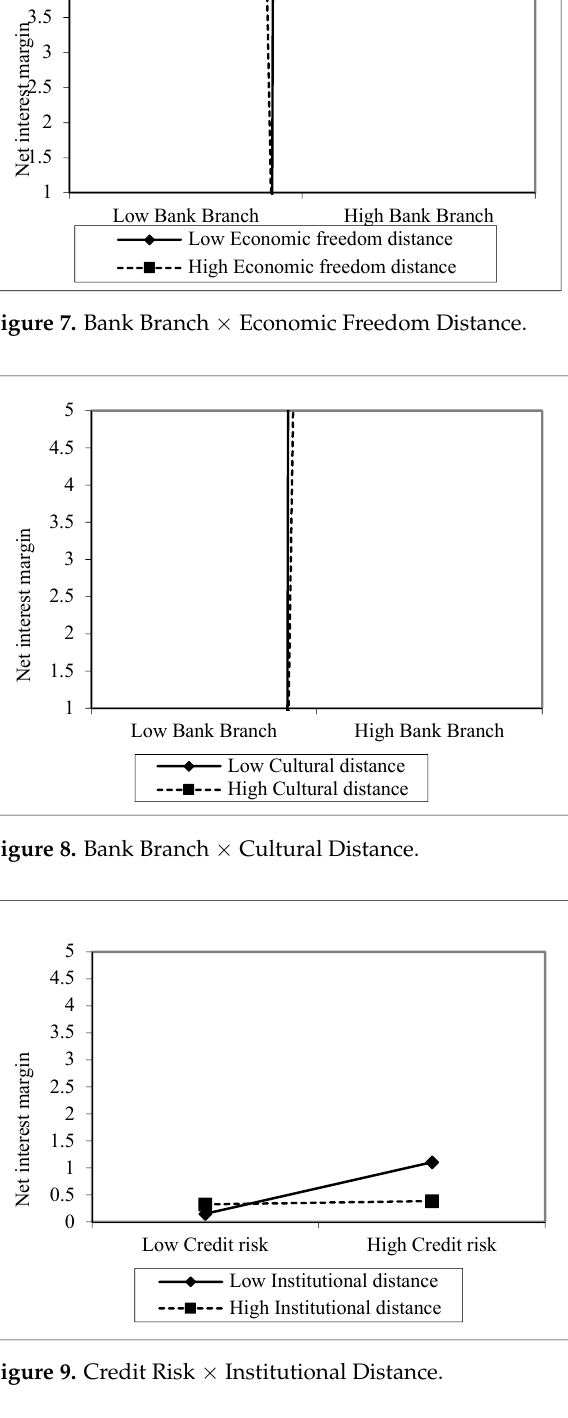
Figure 9. Credit Risk × Institutional Distance.